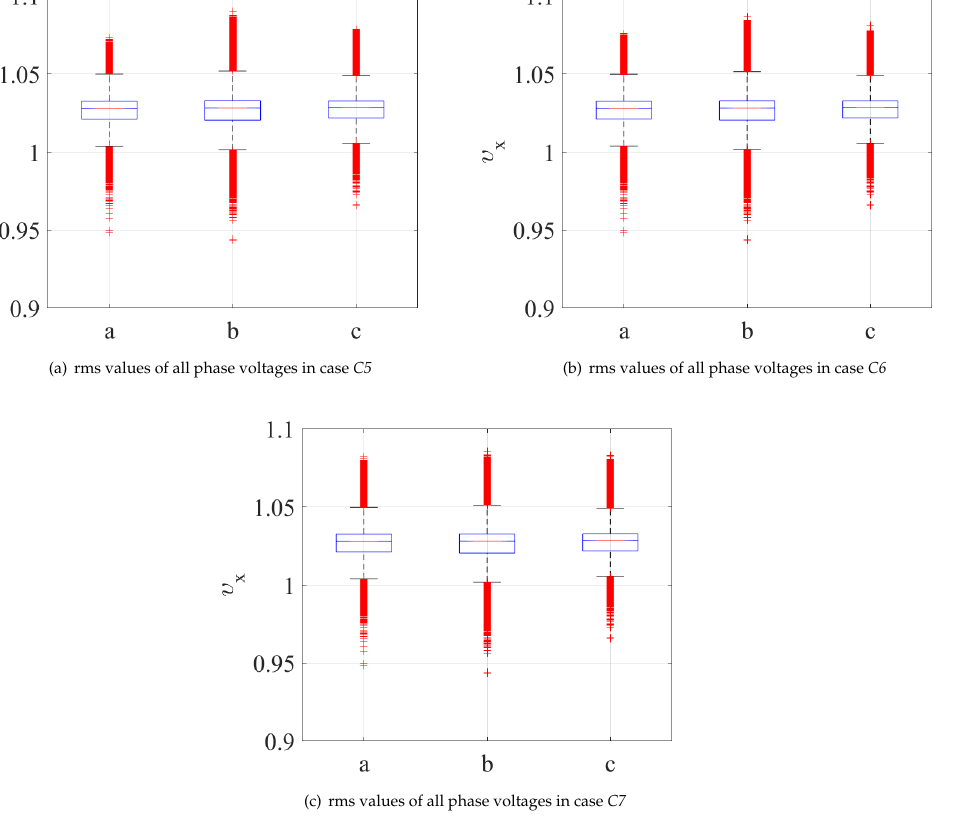
Figure 8. Concatenated voltage results of the entire LV grid when cases C5 to C7 are examined